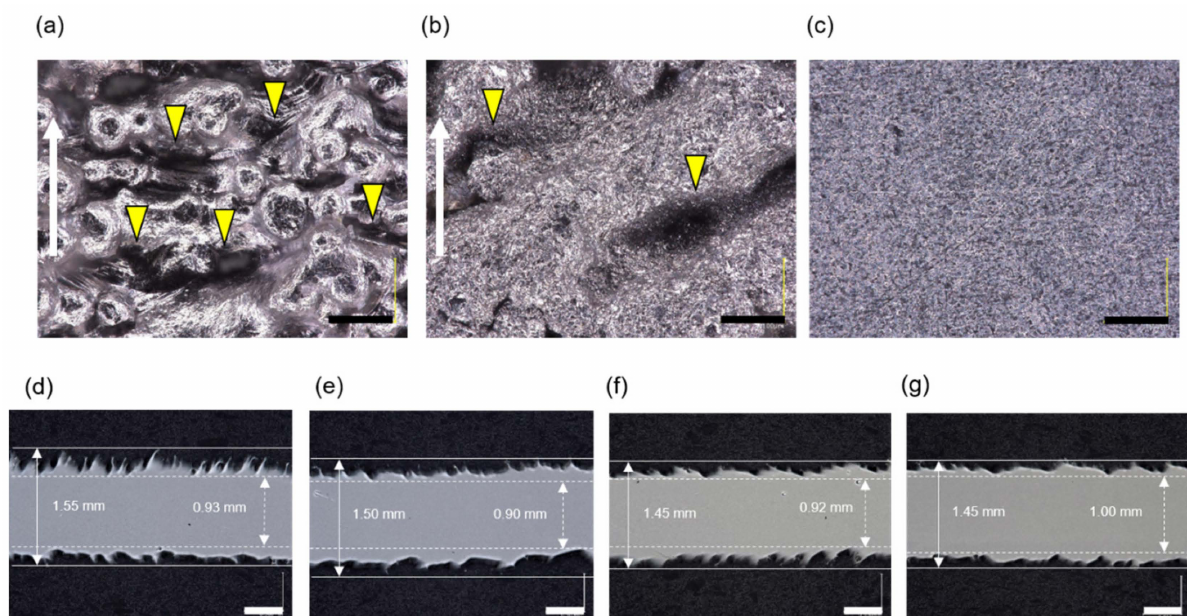
Figure 2. Digital microscope images of each specimen surface of ( a ) untreated, ( b ) alumina sandblast treatment, and ( c ) control. The white arrow indicates the stacking direction. The yellow triangles indicate the grooves. Bar = 100 mm. The grooves are formed in the vertical direction to the stacking direction, with the metal particles on the surface being removed using the alumina blasting treatment. Also shown are pictures of the cross section of the ( d ) PU, ( e ) VU, ( f ) PT, and ( g ) VT specimens. Bars = 0.5 mm. The surface of the specimen stretched parallel to the stacking direction is less rough than that of the specimen vertical to the stacking direction, as the alumina blasting treatment reduces the surface roughness.